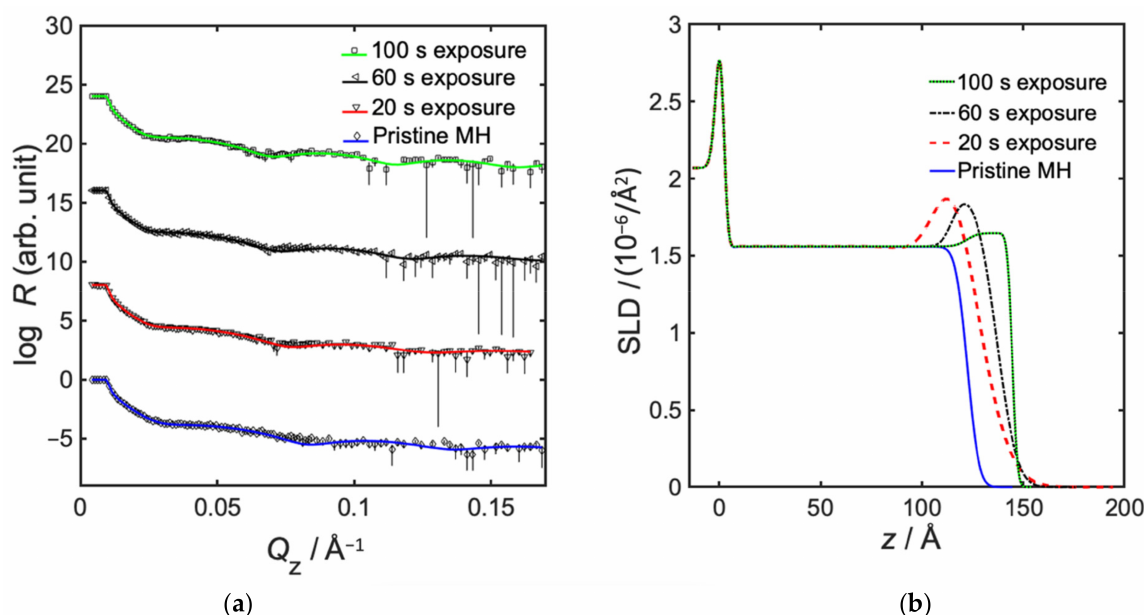
Figure 2. Neutron reflectometry data, showing effect of exposure time in semi-static infiltration of TMA/H 2 O into MH. ( a ) Neutron specular reflectivity profiles, showing measured data with error bars, and fitted models as solid lines; and ( b ) fitted neutron SLD as a function of distance from substrate, where z = 0 represents the interface between silicon and native